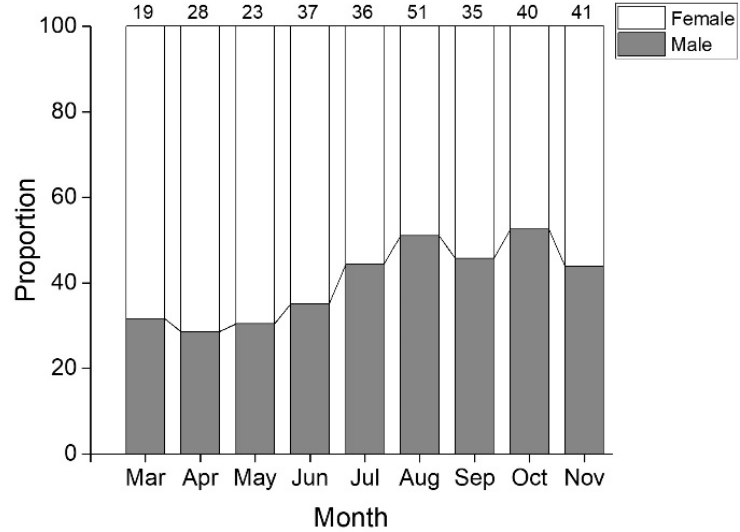
Figure 4. Monthly distribution of the male: female sex ratio in Pseudecheneis sulcatus during the period from March to November 2016. Numbers on bars represent sample size.